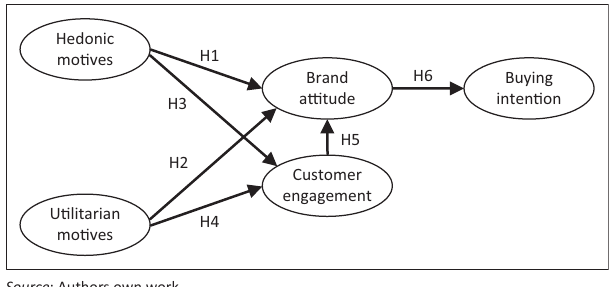
FIGURE 1: Conceptual